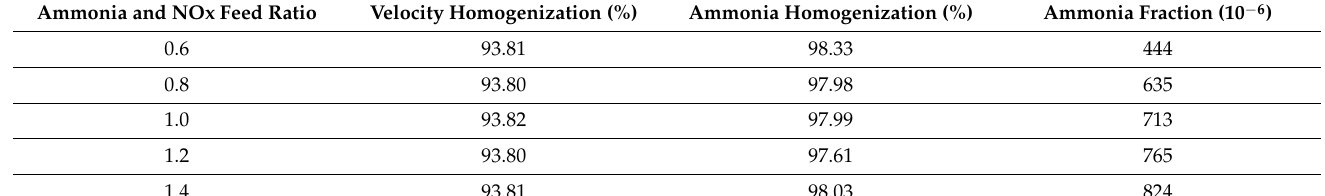
Table 2. Value of parameters at different NH 3 /NOx feed ratios, adapted from Wang et al. [74].